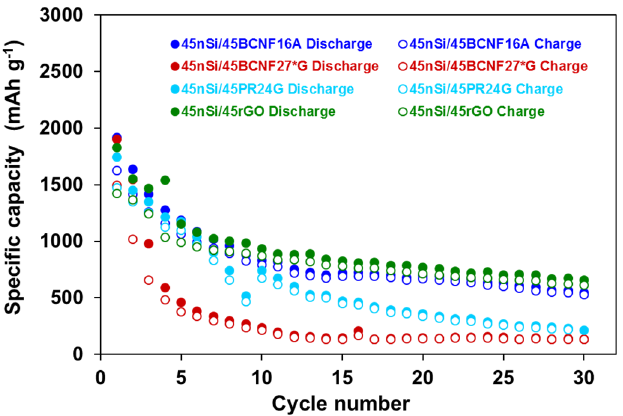
Figure 2. Specific discharge / charge capacity against cycle number plots from the galvanostatic cycling